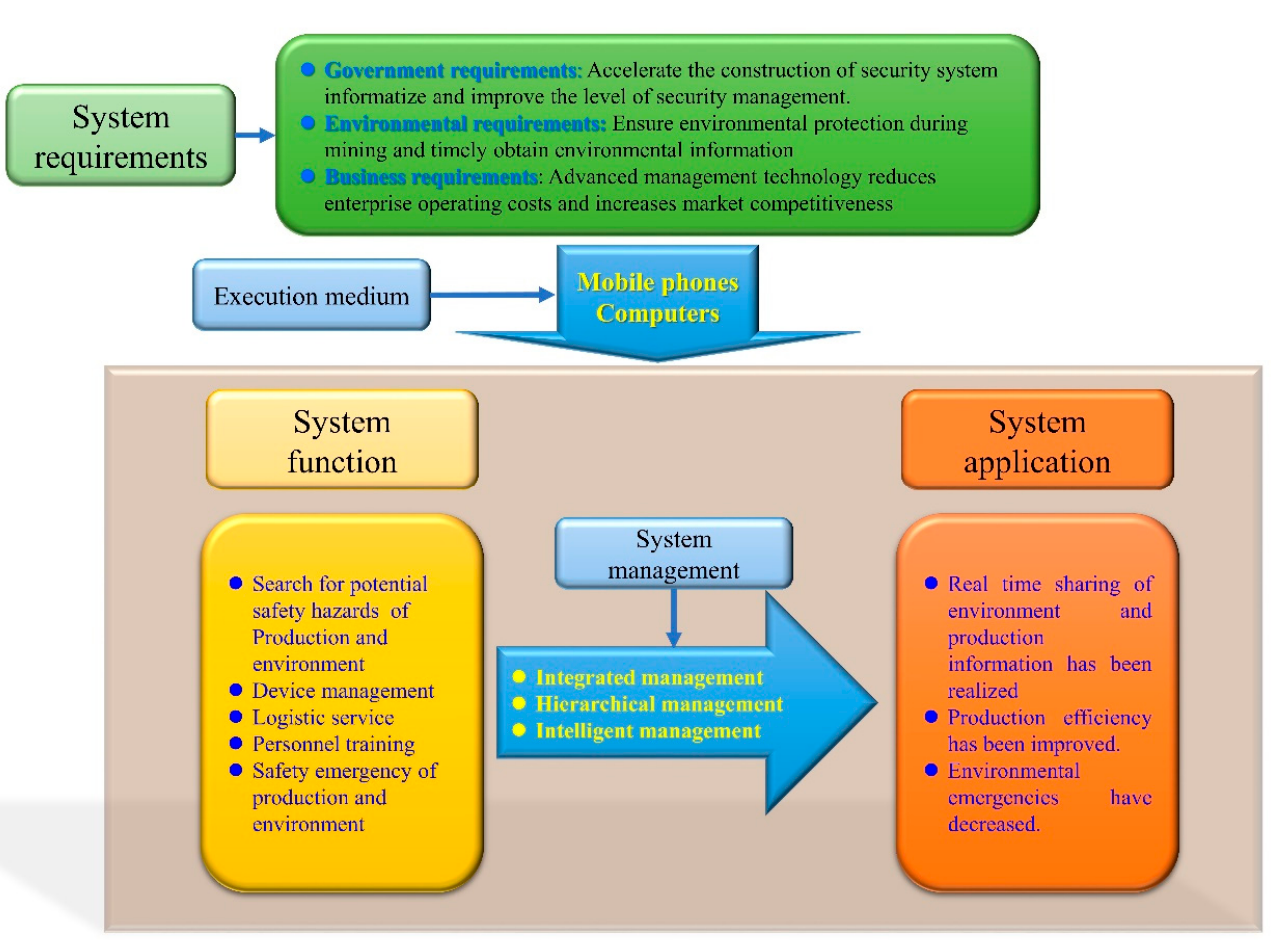
Figure 10. A demonstration security management system of ISL ore mine in Ordos.